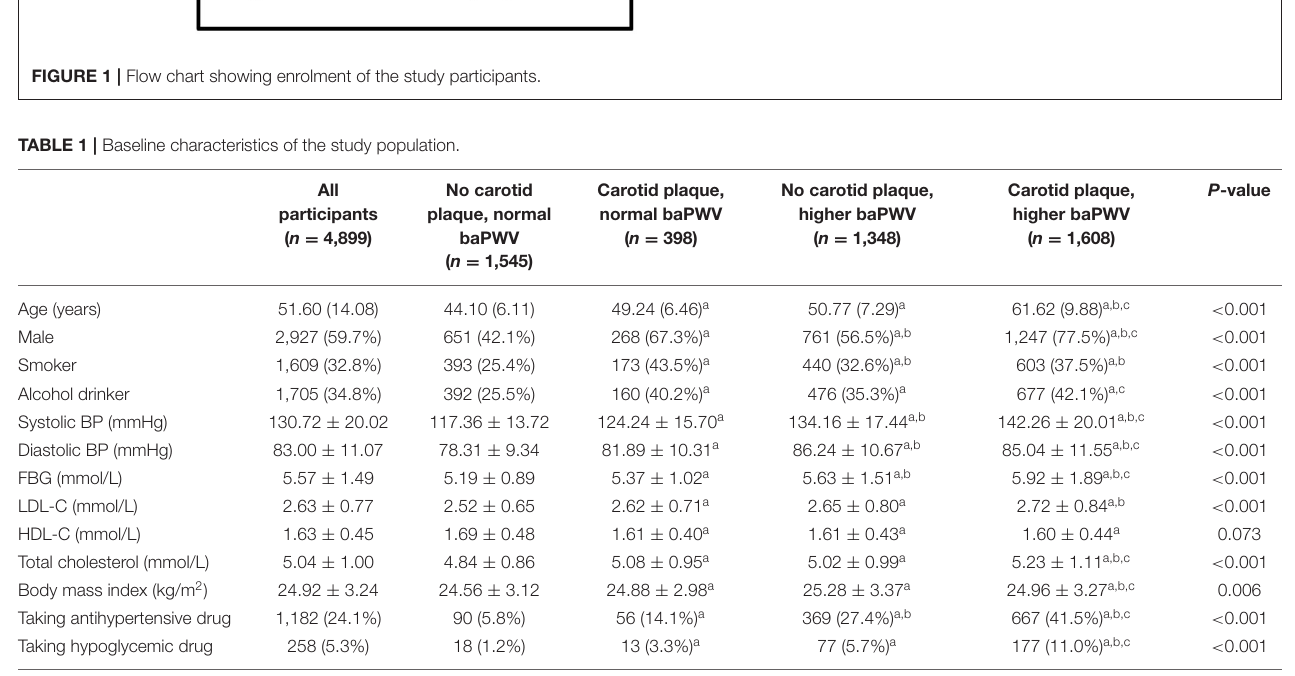
Table 2 . Carotid plaque alone (i.e., with normal baPWV)